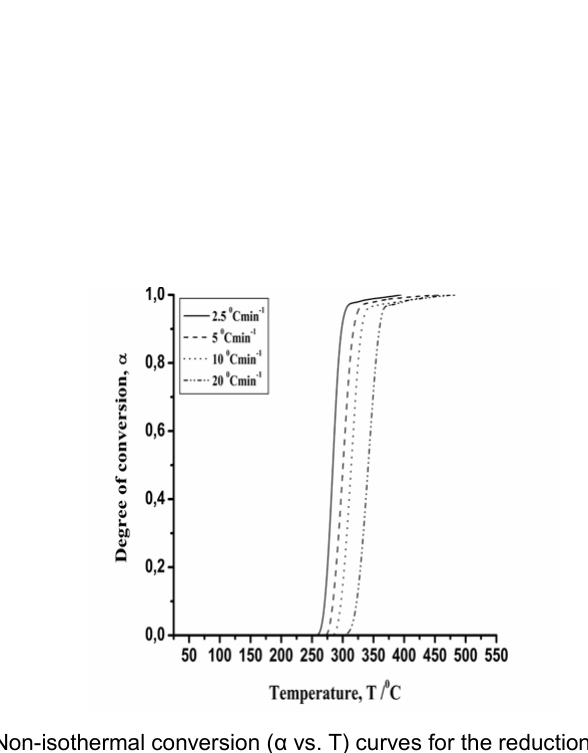
Figure 1 – Non-isothermal conversion ( α vs. T) curves for the reduction process of nickel oxide samples prepared by the gel-combustion method under linearly rising temperature, in hydrogen atmosphere, at the following heating rates (v h ): 2.5, 5, 10 and 20 0 C min -1